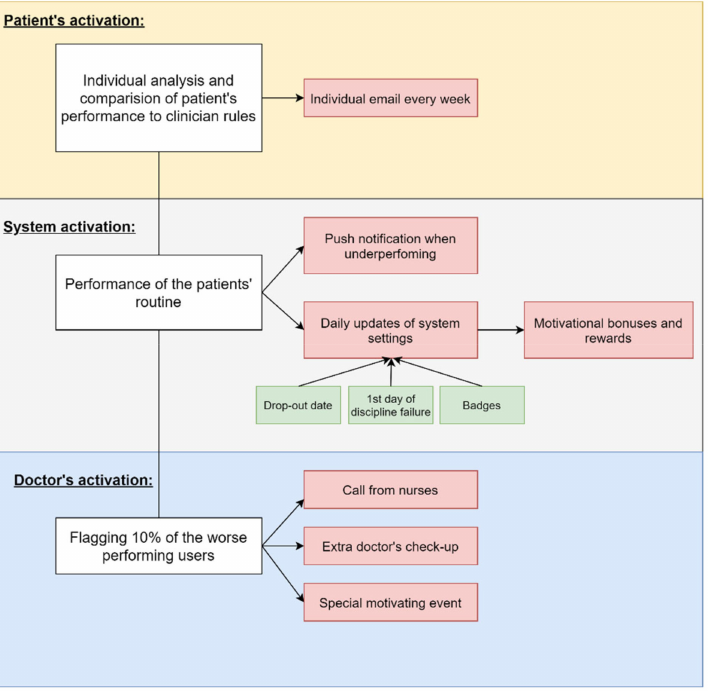
Figure 5. Scheme of three related parts with decision processes that were implemented by the update and represent three layers of system-user